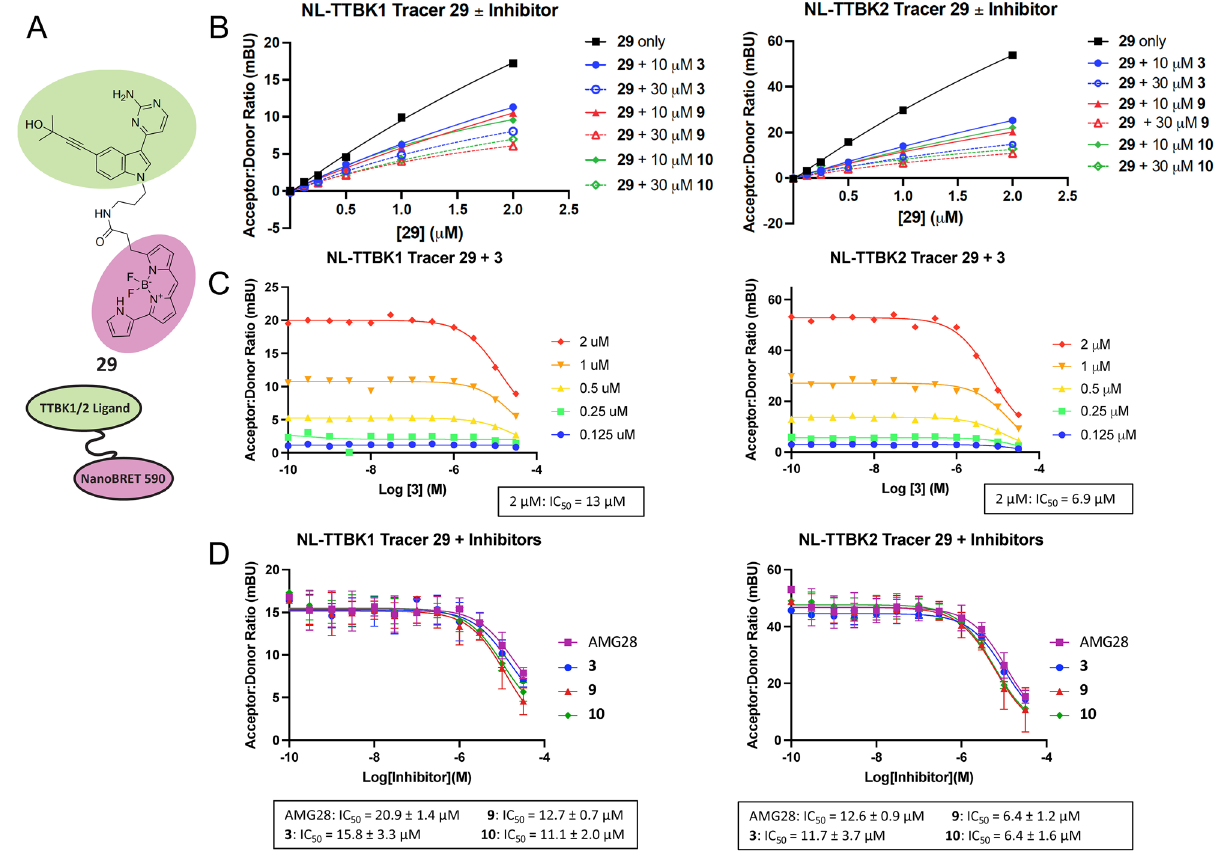
Figure 3. Cell-based NanoBRET assays with TTBK lead inhibitors. ( A ) Structure of tracer 29 . ( B ) Competition experiments between tracer 29 and analog 3 , 9 , or 10 at either 10 or 30 µM for NLuc-TTBK1 and NLuc- TBK2, n = 1. ( C ) Tracer titration results for NLuc-TTBK1 and NLuc-TTBK2 in the presence of analog 3 , n = 1. Calculated